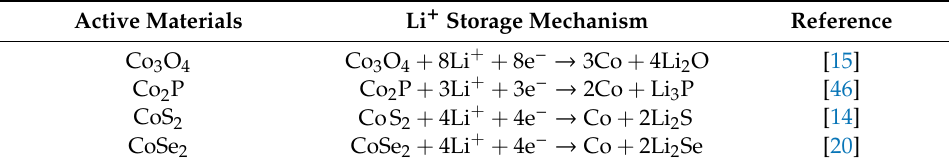
Table 1. Li + storage mechanism of some Co x A y -active